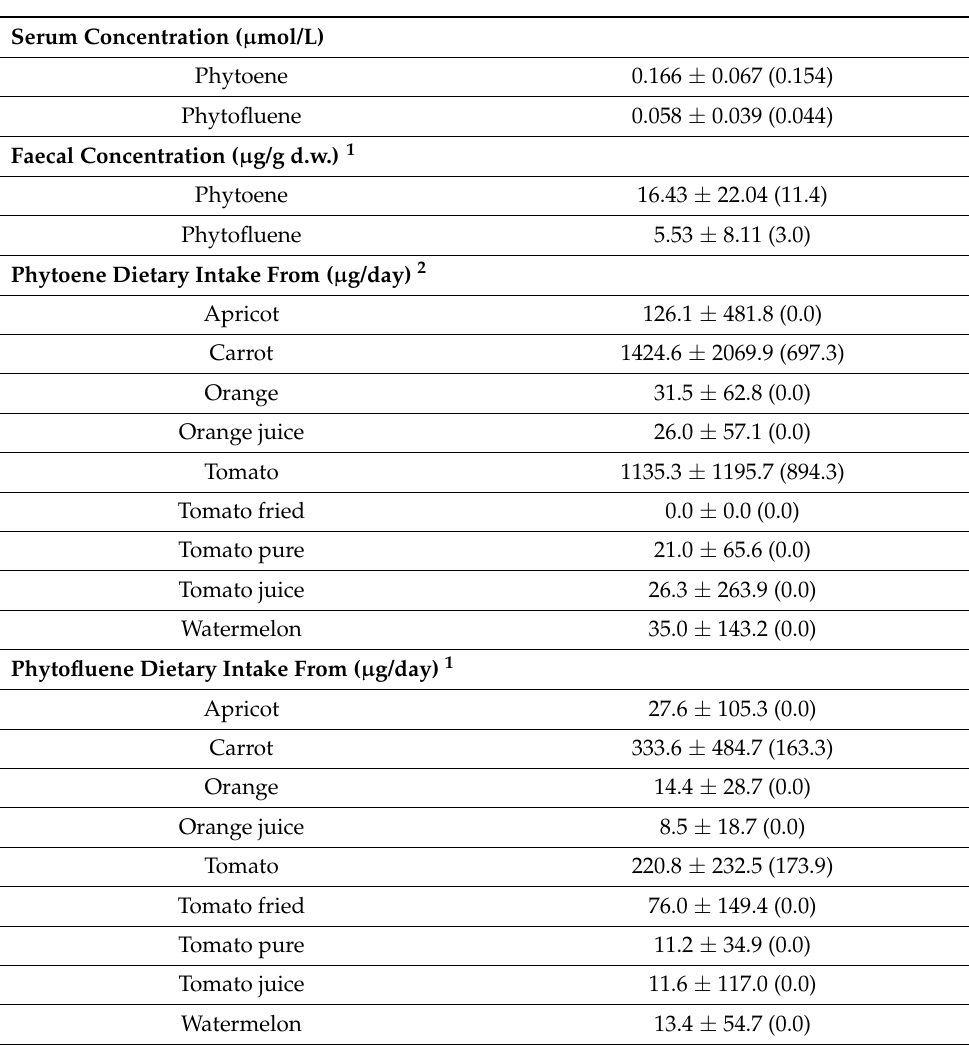
Table 1. Phytoene and phytofluene concentrations in serum ( µ mol/L), faeces µ g/g (dry weight) and dietary intake from major contributors to their dietary intake ( µ g/day) in the observational study ( n = 101) (mean ± SD [median]). Serum Concentration ( µ mol/L) Phytoene 0.166 ± 0.067 (0.154) Phytofluene Faecal Concentration ( µ g/g d.w.) 1 Phytoene Phytoene Dietary Intake From ( µ g/day)